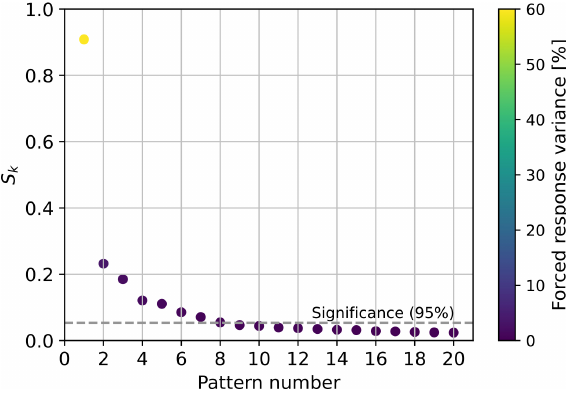
Figure 2. Signal fraction of the leading S/N M EOF patterns along with their respective explained forced response variance (%). The significance level (95%) computed using 30-year block bootstrap- ping is represented as a dashed line. Patterns are sorted based on the magnitude of their signal fraction, as illustrated in Fig.